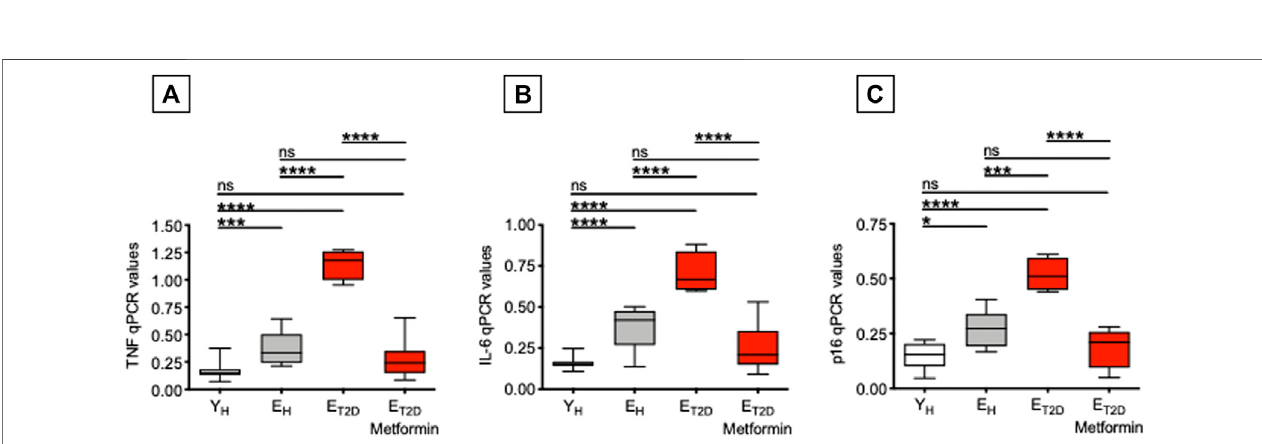
FIGURE 3 | Metformin decreases mRNA expression of SASP markers in ex vivo-isolated B cells from E T2DM patients. B cells were resuspended in TRIzol, then the RNA was extracted and the expression of SASP markers detected by qPCR to evaluate expression of RNA for the pro-in fl ammatory cytokines TNF- α (A) and IL-6 (B) , and for the cell cycle regulator p16 INK4 (C) . qPCR values are measures of RNA expression of target genes, relative to the housekeeping gene GAPDH, calculated as 2 − Δ Cts . Mean comparisons between groups were performed by one-way ANOVA. * p < 0.05, *** p < 0.001, **** p < 0.0001.